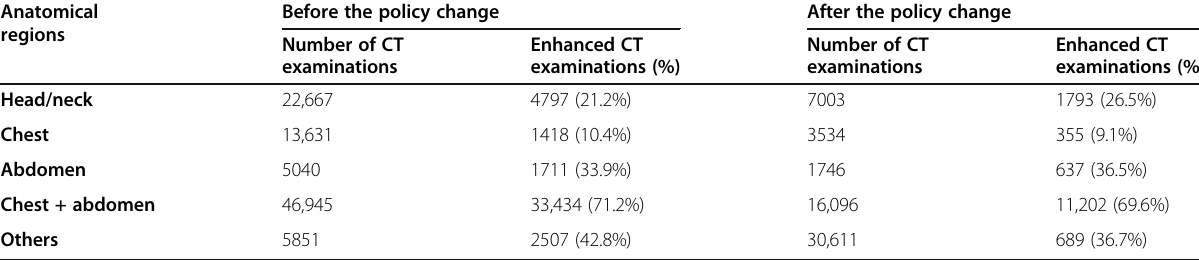
Table 1 Number of CT examinations during the survey period Anatomical regions